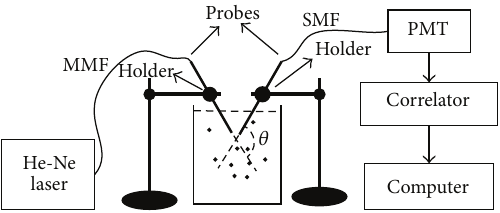
Figure 2: Optical fiber dynamic light scattering nanometer particle sizing